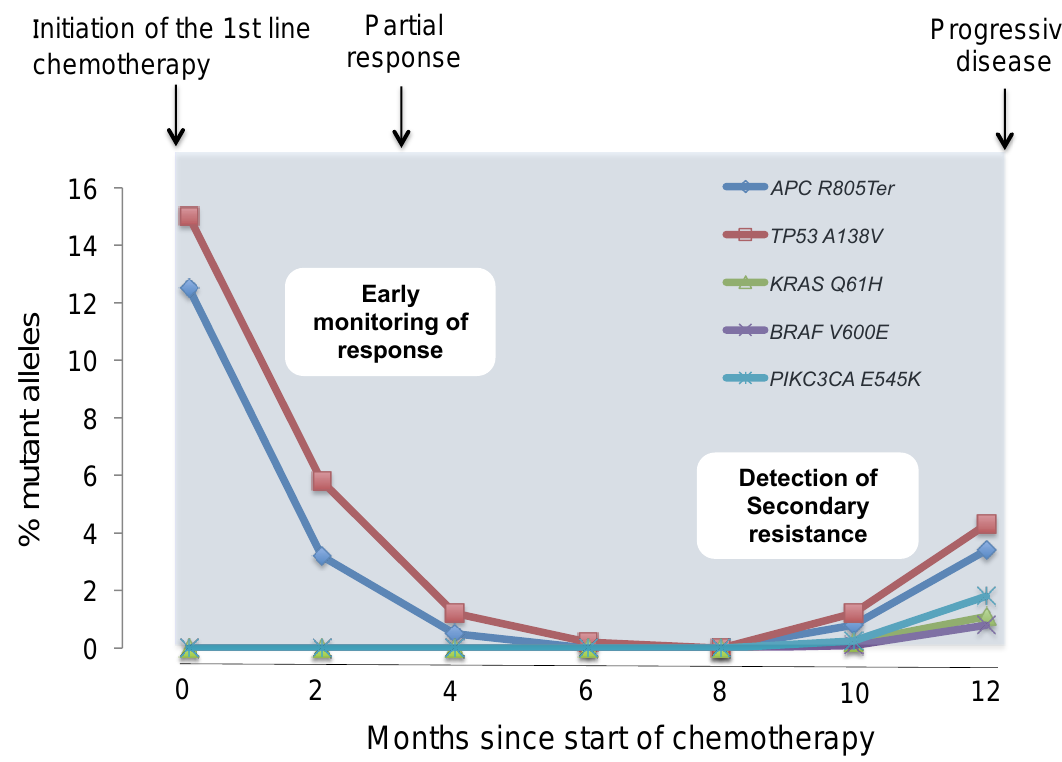
Figure 2. Evaluation of chemotherapeutic response and prediction of resistance to chemotherapy. Serial tumor-specific mutation analysis in the blood of patients is useful to monitor response and resistance to molecular targeted drugs. Early decrease of mutant allele after chemotherapy may predict better therapeutic response and clinical outcomes. Furthermore, liquid biopsies can detect the emergence of resistant clones of chemotherapy before radiographic confirmation of disease progression. This figure reflects a representative case of our own original data.